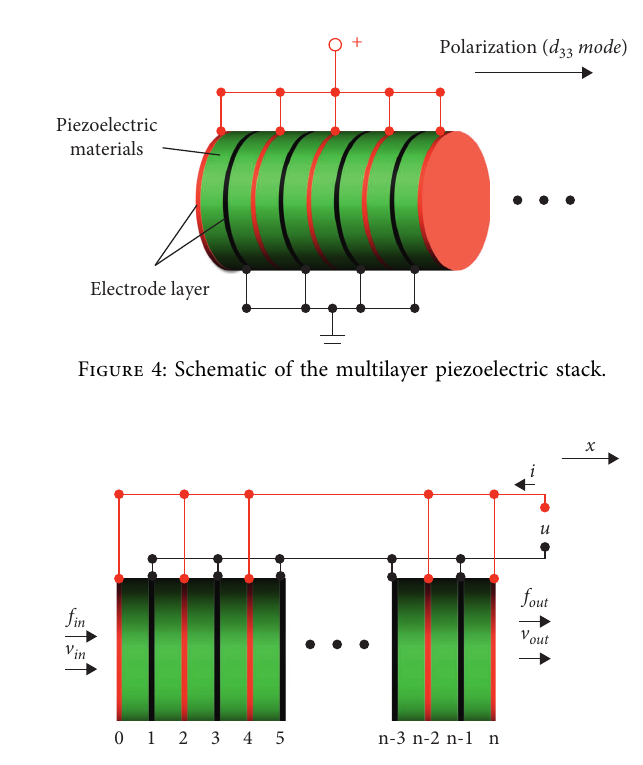
Figure 5: Electromechanical coupling model of piezoelectric stack